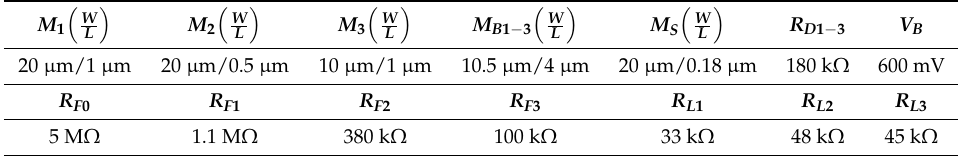
Table 1. Component values and transistor aspect ratios for the proposed transimpedance